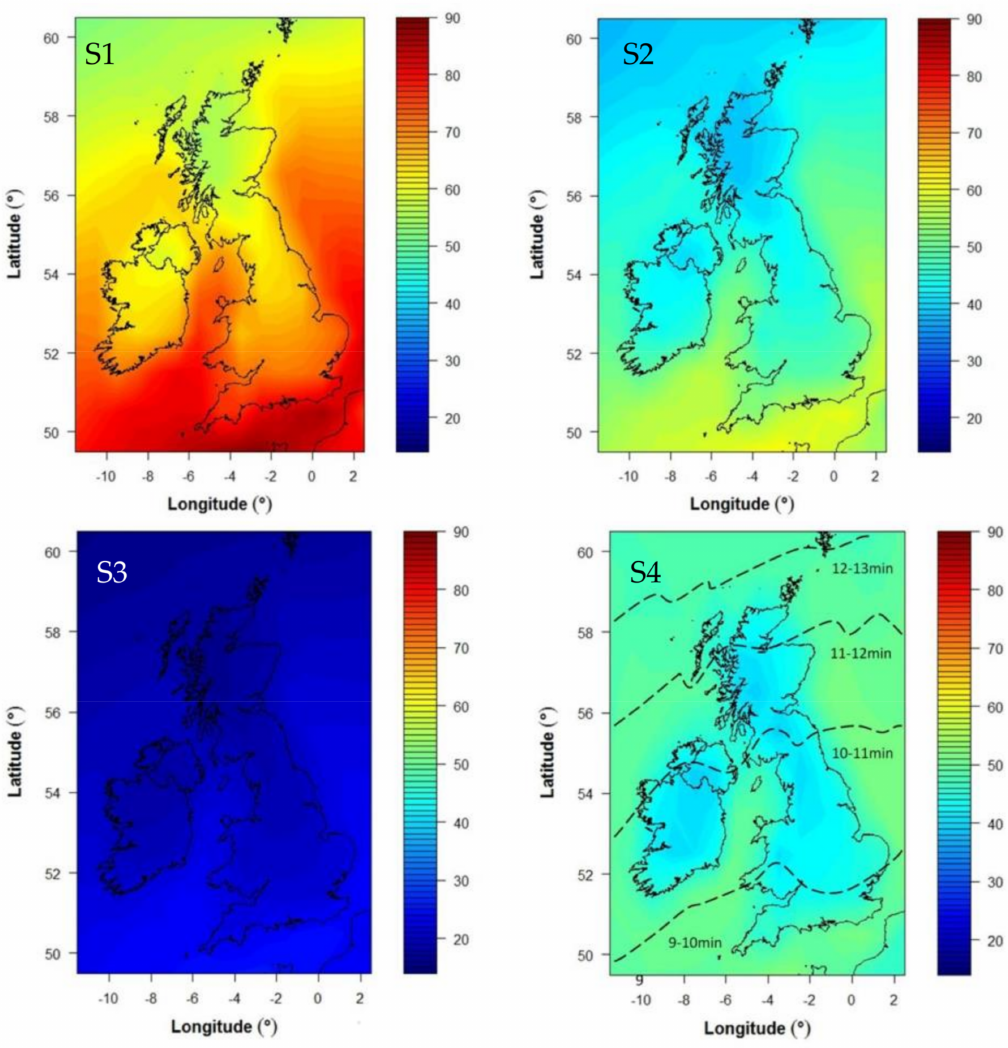
Figure 2. Calculated UVR doses in SEDs achievable from March-September on a randomly oriented vertical surface based on a 10-year UVR climatology [18] and daily exposures of <1 SED around noon for scenarios S1–S4 (Table 2). S1–S3 show the dose achieved after daily 9 min exposures at noon with 35% of skin area exposed March–September (S1). 10% of skin area in March–May and September, 35% June–August (S2). 10% of skin area throughout March–September (S3). S4 indicates the dose acquired after an exposure for a time equivalent to approximately 1 SED on 35% of skin area between June–August (no exposure in other months). For S4, exposure bands are labelled in minute intervals with the time to achieve 1 SED. While incident solar radiation is independent of skin area exposed, it is only effective for vitamin D synthesis when it falls on exposed skin. Therefore, the incident UVR has been scaled by the skin area for S2 and S3 to give “effective UVR” relative to the baseline skin area (35%) exposed in S1, which has a scaling factor of 1. See Method Section 2.3 for further details. The vertical color gradient key shows the number of indicative SED such that pale blue reflects achievement of the target dose ( ≥ 38 SED; S2 and S4), dark blue shows failure to achieve target (S3), and yellow-red shows the target is more than achieved (S1). The data illustrated are equivalent to E in Figure 1 for scenarios S1–S4 while the target dose (38 SED) is C in Table